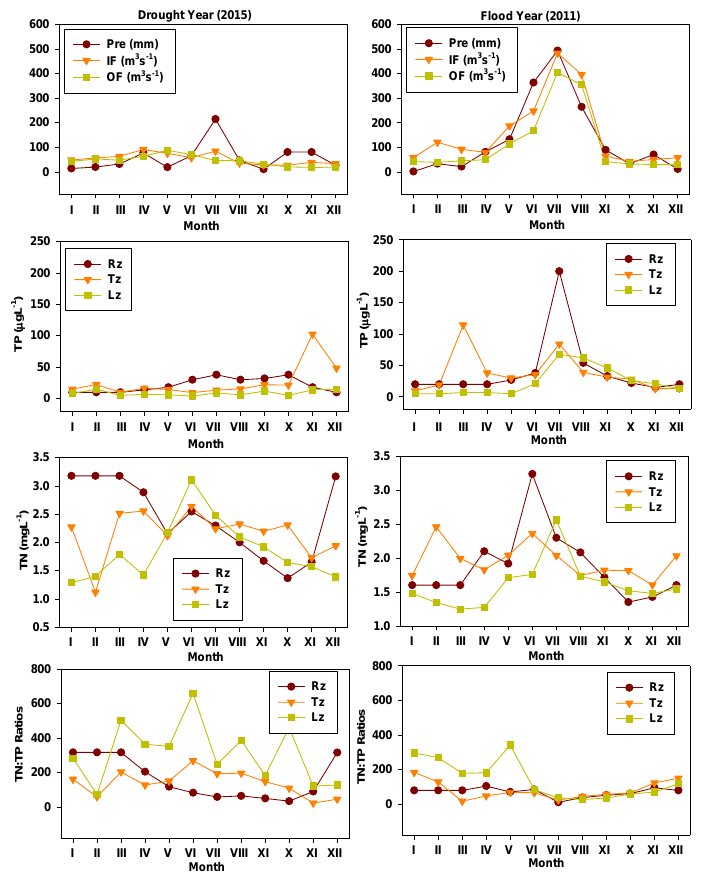
Figure 3. Monthly variation of drought year (2015) and flood year (2011) hydrological parameters (pre: precipitation, IF: inflow, and OF: outflow) and nutrients (TP, TN, and TN:TP ratios) in Rz, Tz, and Lz zones (Rz: riverine zone, Tz: transitional zone, Lz: lacustrine zone, TP: total phosphorus, TN: total nitrogen, I–XII: January–December).